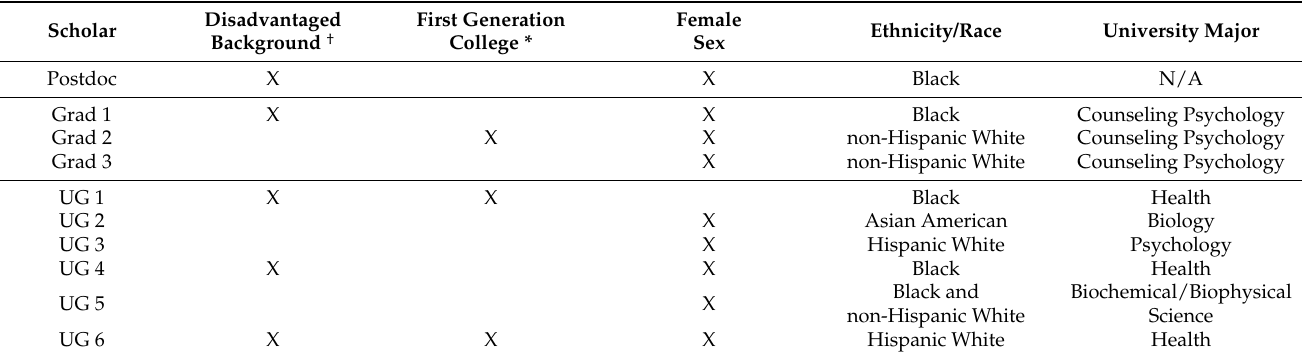
Table 1. UHAND Program Participants, Cohort 1 (N =